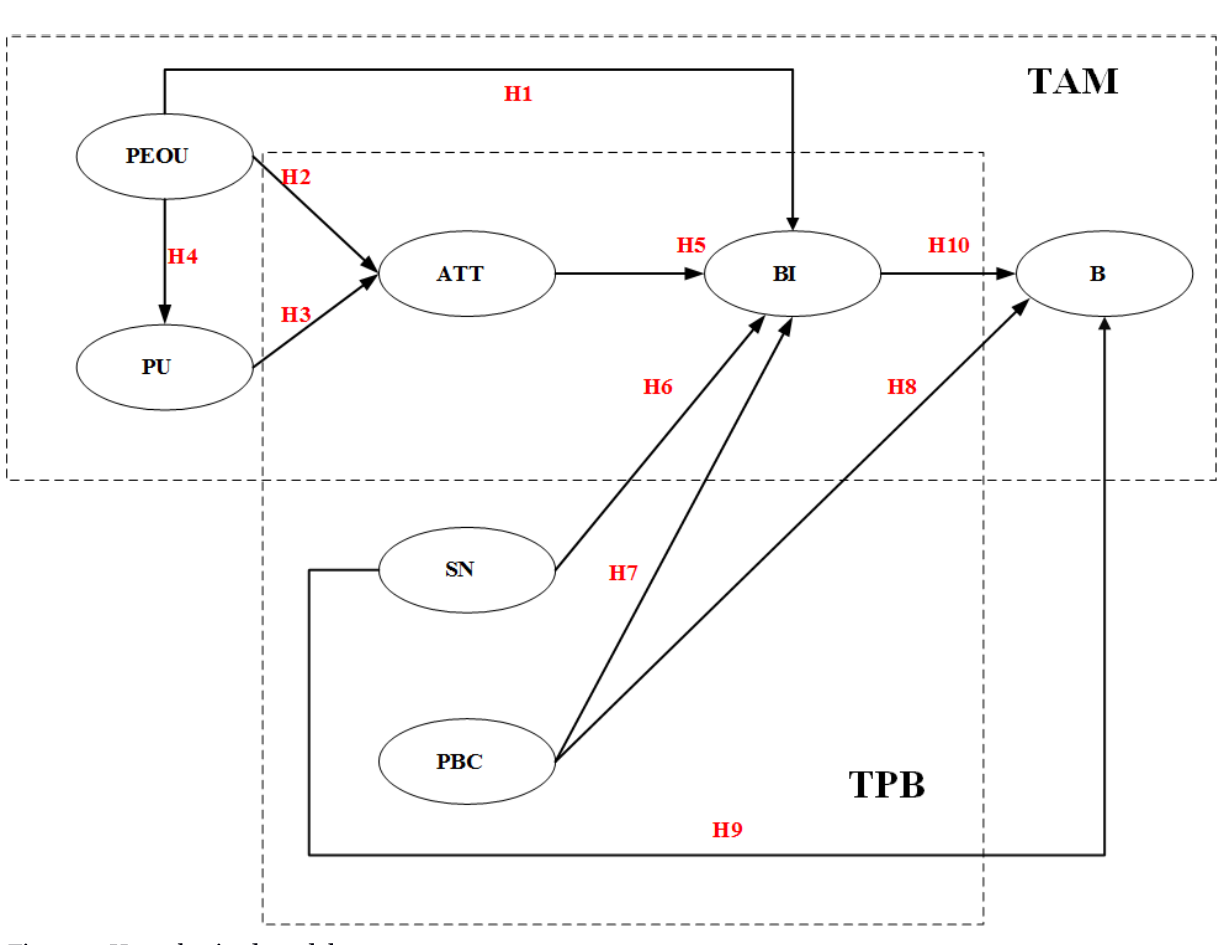
Figure 1 . Hypothesized